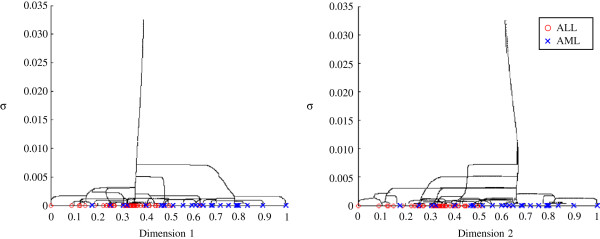
Sigma evolution on the Golub dataset. The two dimensions of the Golub dataset are split into two separate graphs. The illustrations show that as σincreases the cluster centres merge and eventually become a single cluster.